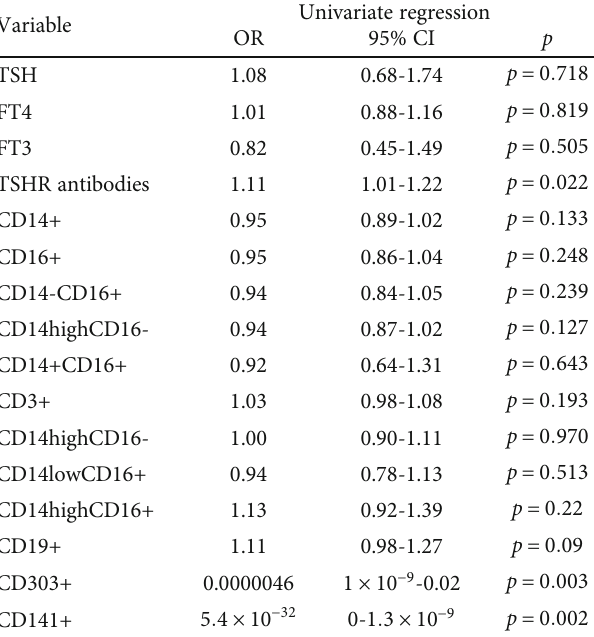
Table 3: Univariate logistic regression analysis of the univariate GO determinants (variables), performed in all patients, i.e., with and without (controls, GD) GO. OR: odds ratio; CI: con fi dence interval. Values p < 0 : 05 are considered statistically signi fi